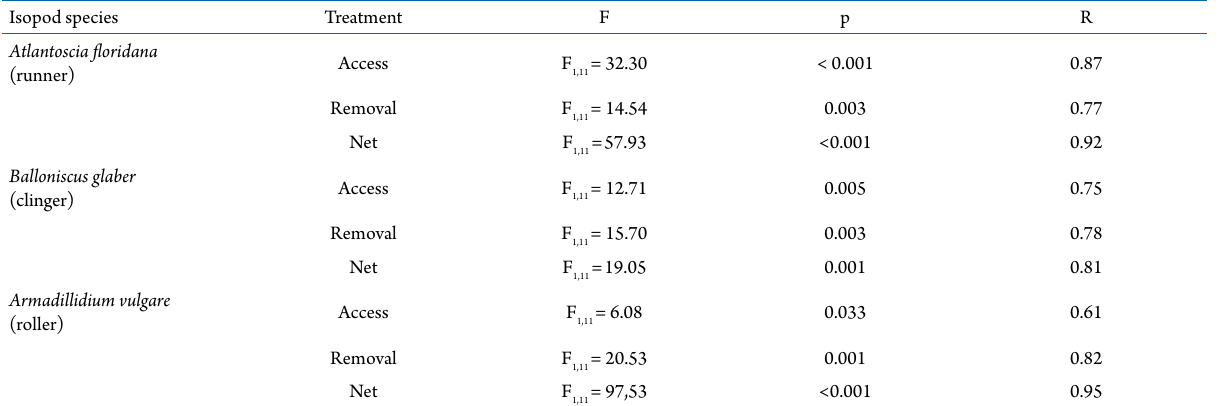
Table 3. Pearson correlation of cumulative survivorship and time of three isopod species in feeding experiments with treatments access, removal and